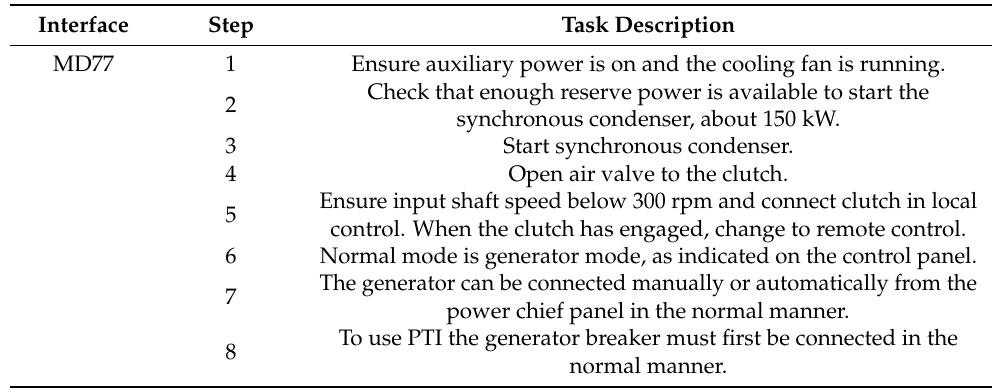
Table 2. Shaft generator operation